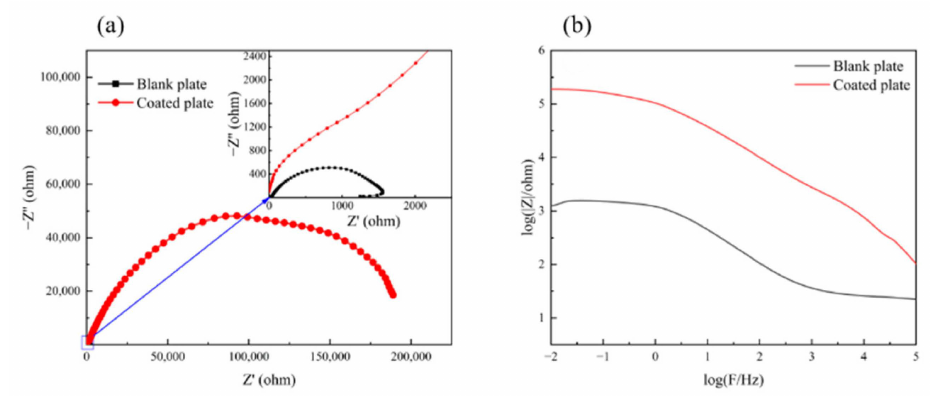
Figure 6. The EIS test results: ( a ) Nyquist plots and ( b ) Bode plots. Figure 7 is the test result of the Tafel polarization-curve test carried out on blank plates and coated plates. Table 1 shows the fitting parameters of the Tafel polarization curve.